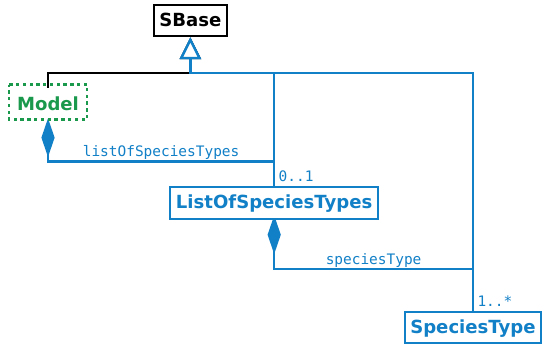
Figure 1: The extension of the Model